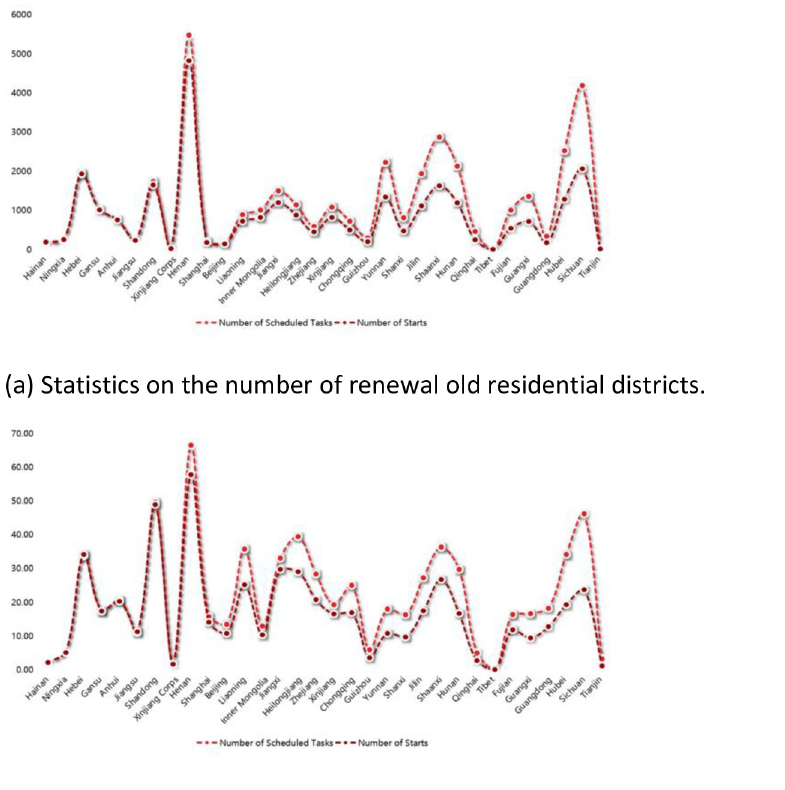
Fig 2. The progress of renovating old residential districts. (a) Statistics on the number of renewal old residential districts. (b) Statistics on the number of households (thousands of households).